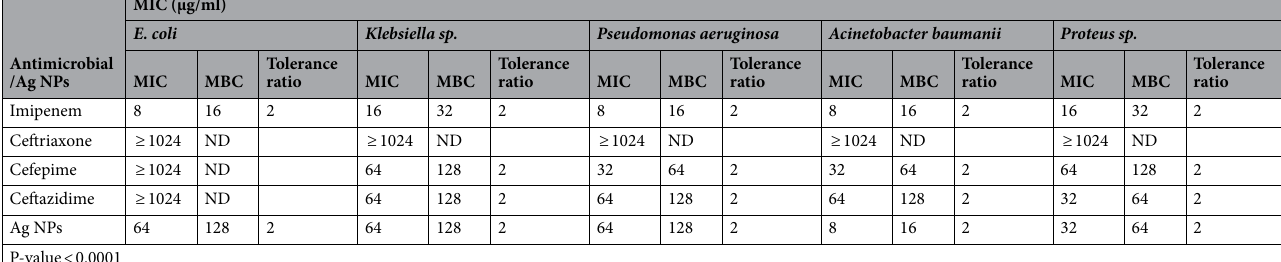
Table 4. Antimicrobial activity of antimicrobials and biosynthesized Ag NPs against CPGB. MIC: Minimum inhibitory concentration, MBC: Minimum bactericidal